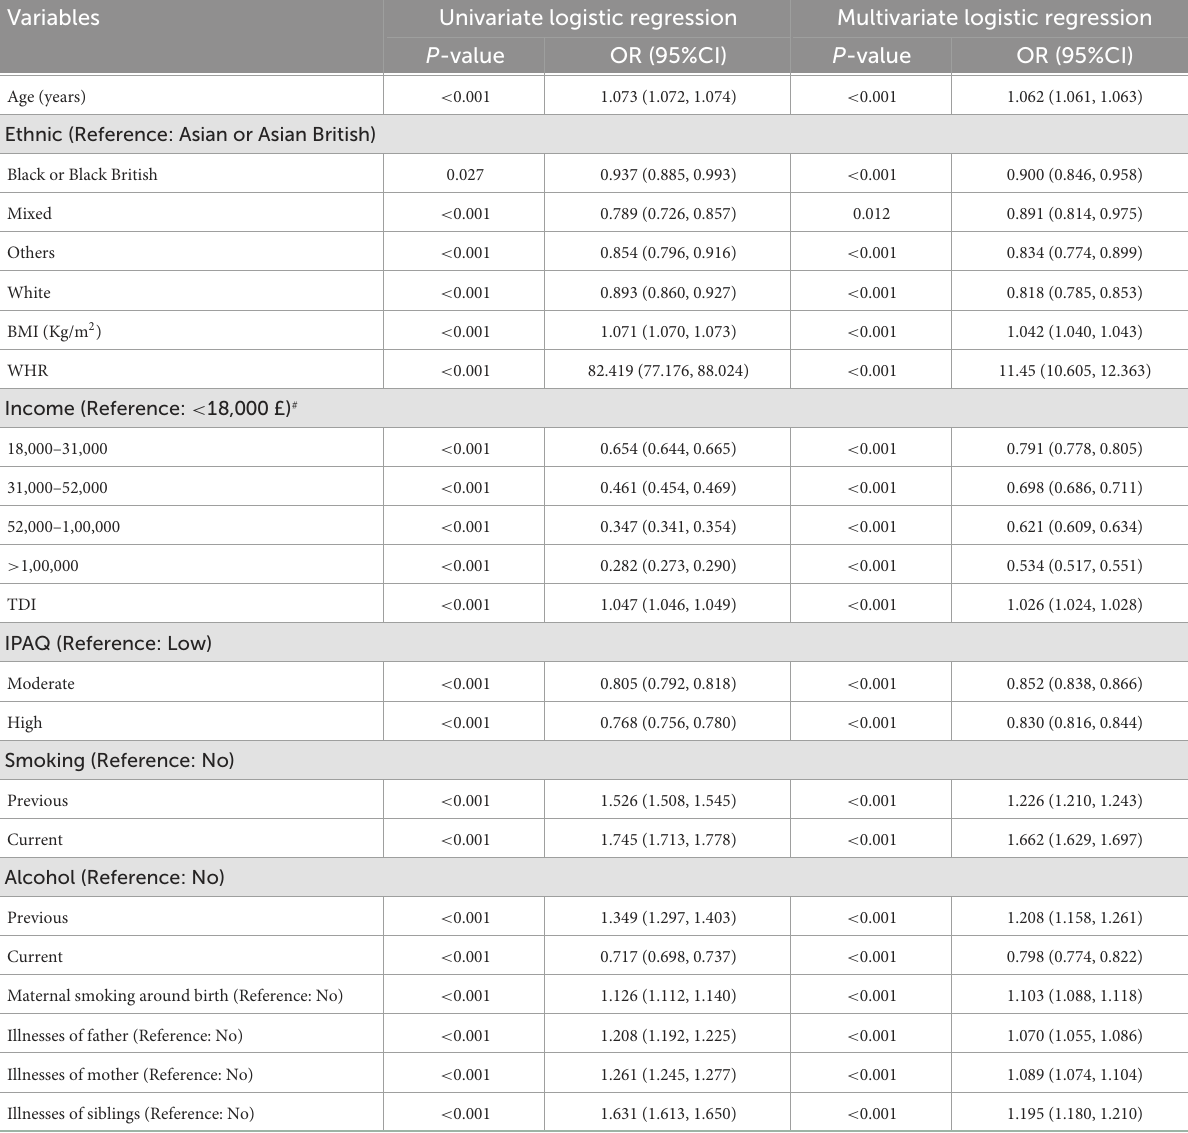
TABLE 2 Univariate and multivariate logistic regression analyzes of factors influencing CCI in all participants [Median (Q1, Q3)/ n (%)]. Variables Univariate logistic regression Multivariate logistic regression